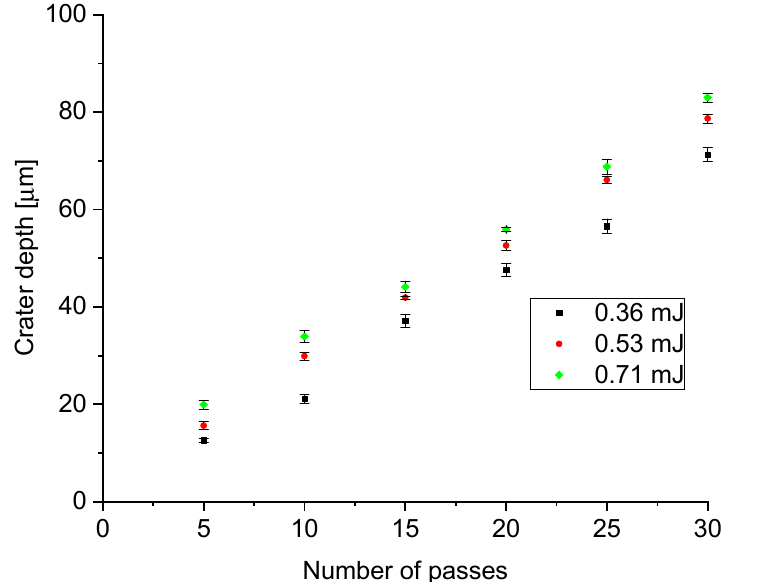
Figure 5. Crater depth as a function of the number of laser passes for three different pulse energies. Results presented for the 20 W laser.